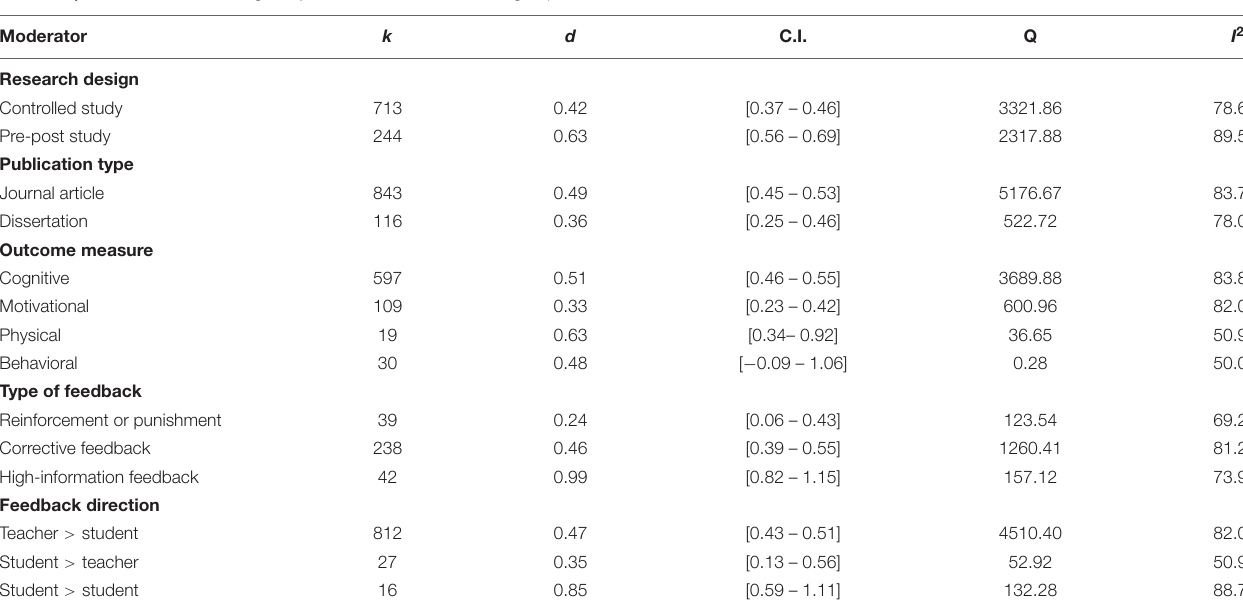
TABLE 3 | Effect sizes and heterogeneity for different moderator